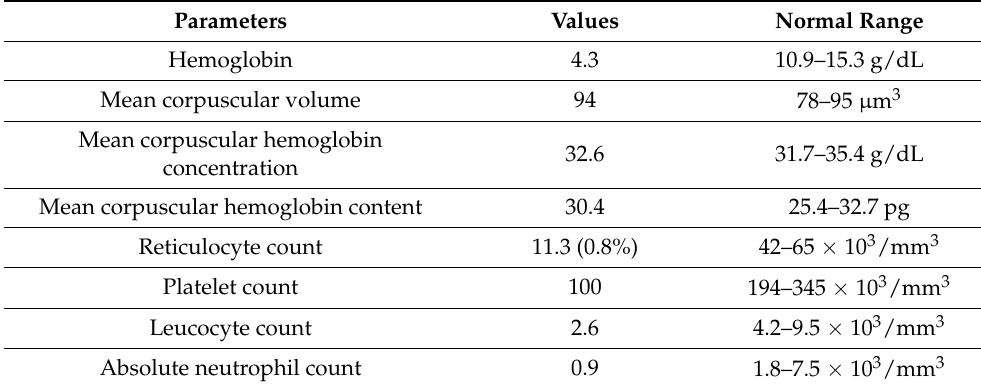
Table 1. Hemogram parameters. Parameters Values Normal